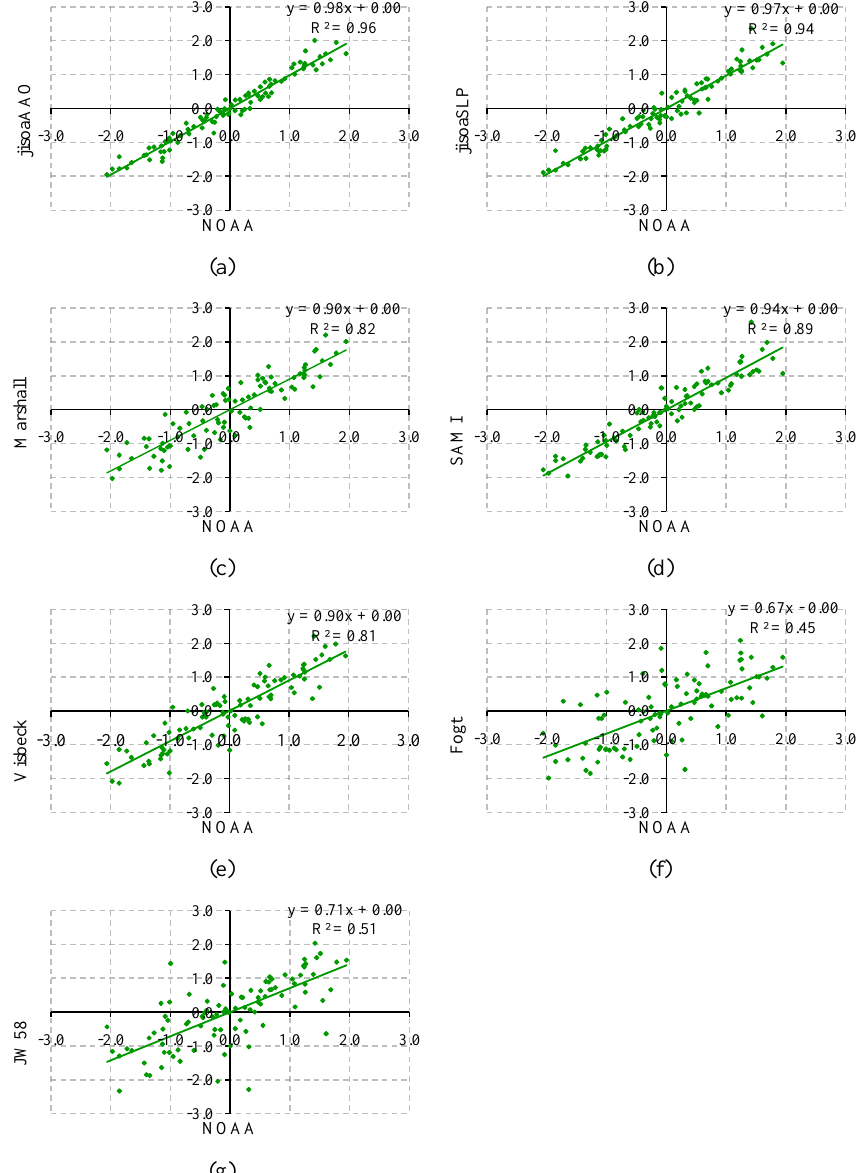
Fig. 1. Seasonal SAM index values plotted against seasonal NOAA index (normalised 1979–2002) for (a) jisaoAAO; (b) jisaoSLP; (c) Mar- shall; (d) SAMI; (e) Visbeck; (f) Fogt and (g)